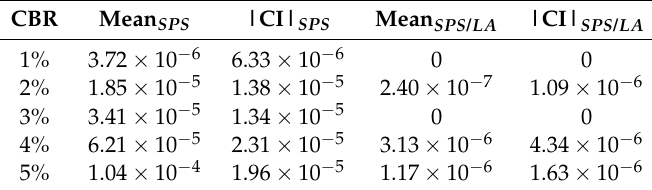
Table 2. Collision probability at t = 100 with 95% confidence interval (CI) width.